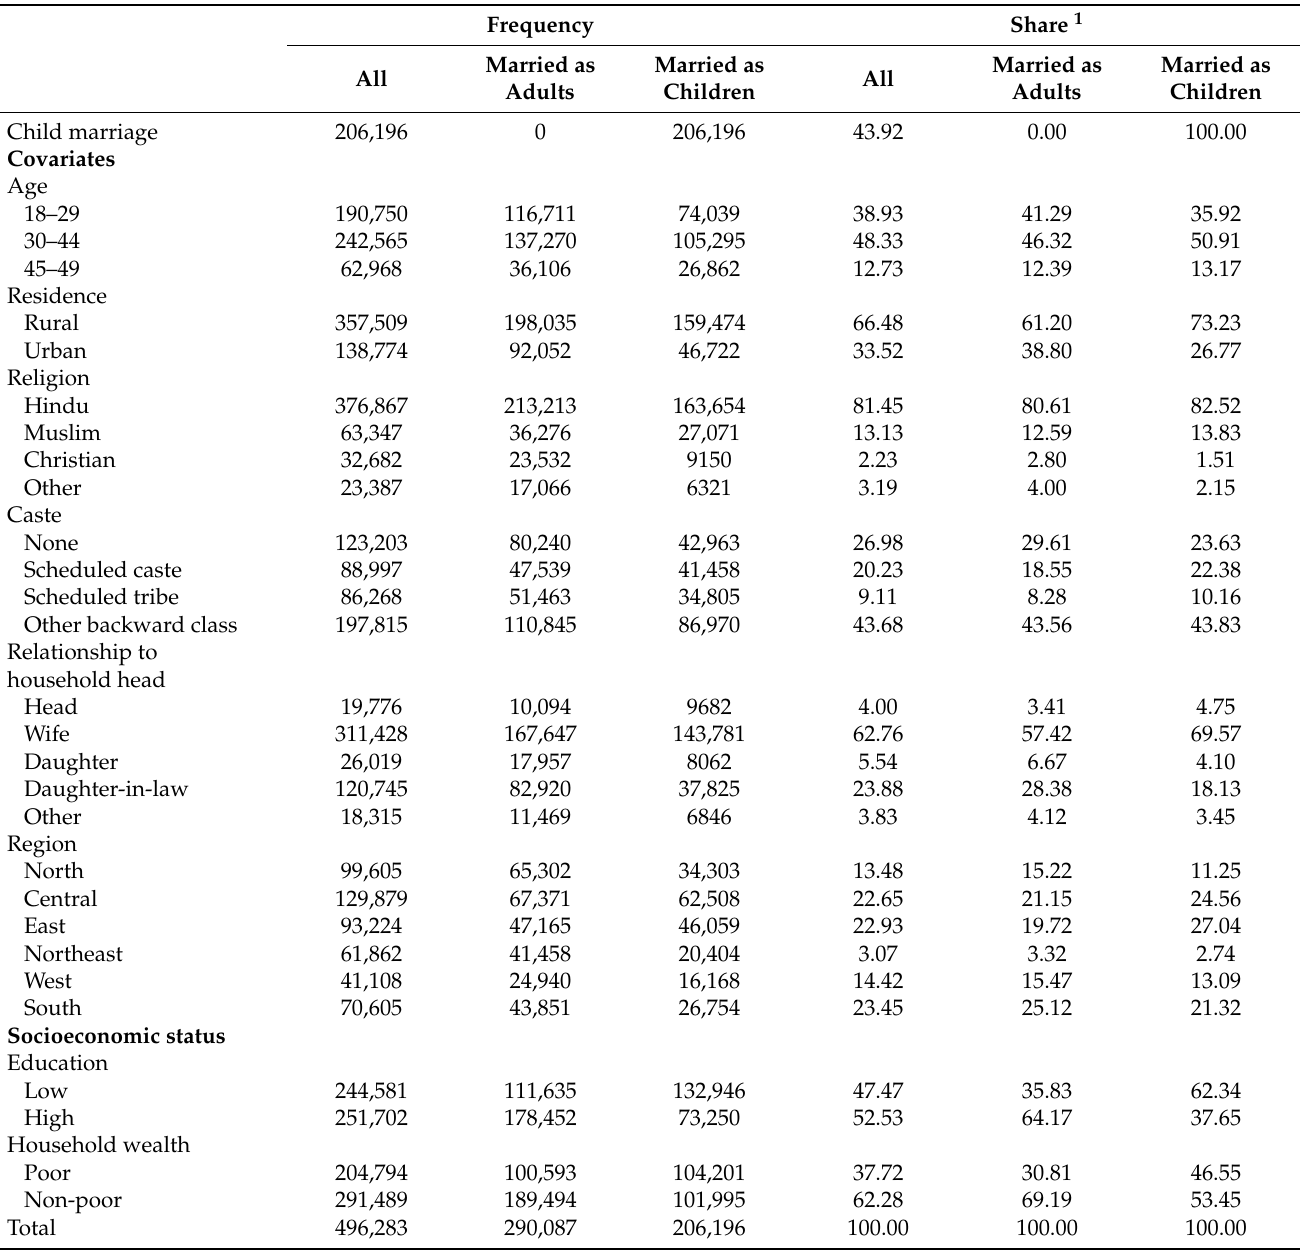
Table 1. Background characteristics of the study participants grouped by marriage